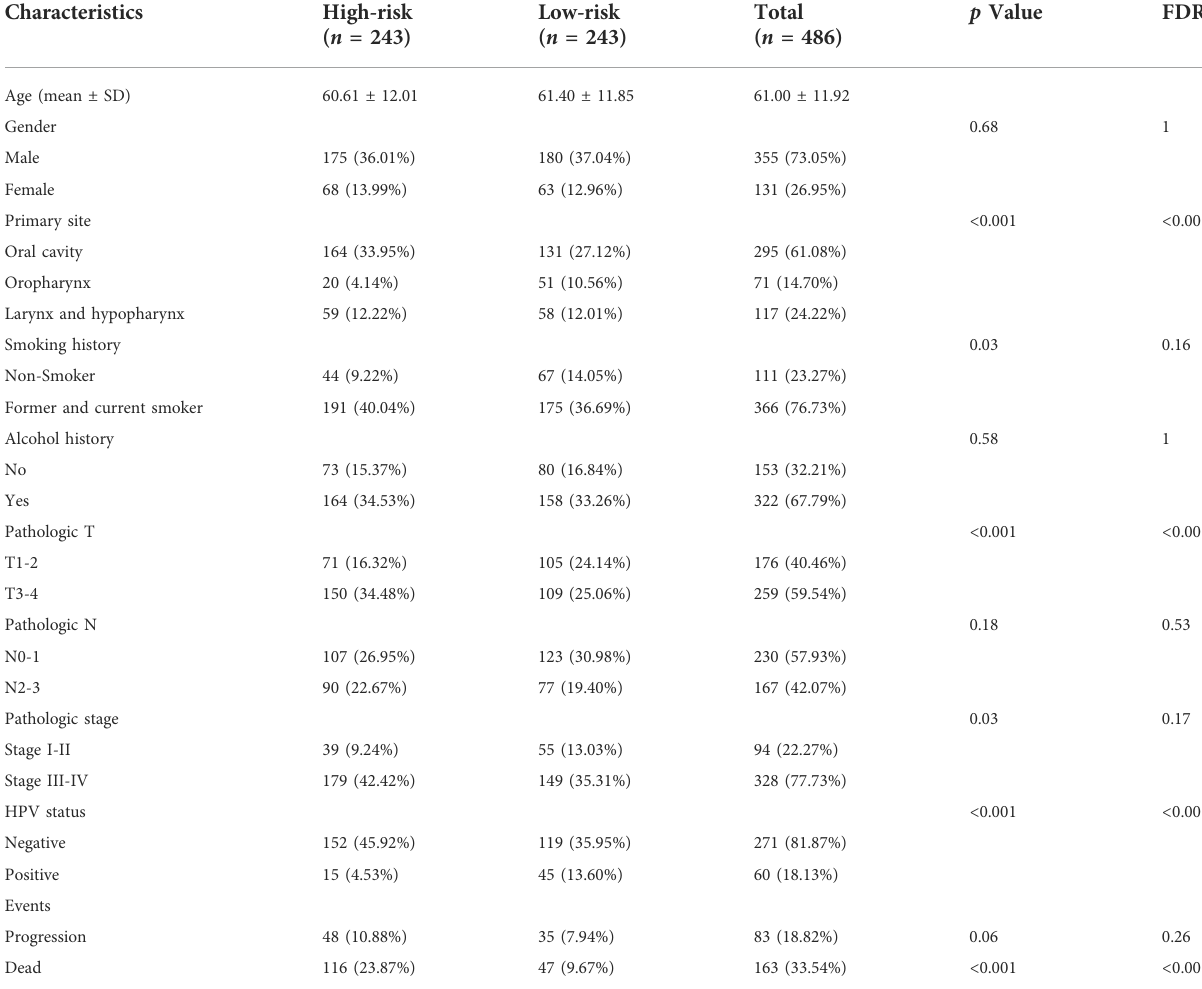
TABLE 1 Correlation between risk score based subgroups and clinical